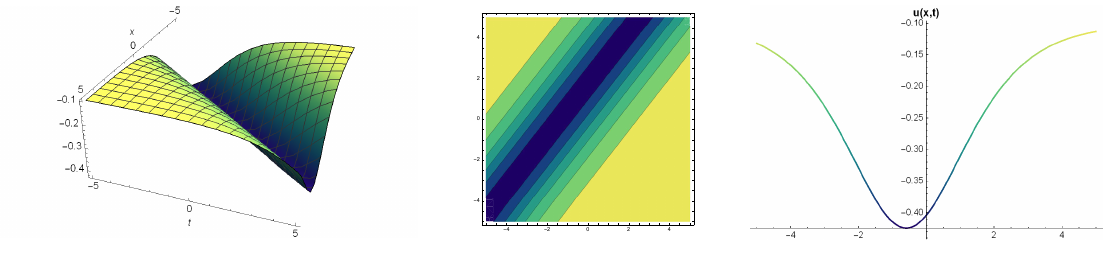
Figure 2. 3D, contour and 2D graphs respectively for p = − 1, µ = − 0.8, A = − 3, a 2 = − 1, a 1 = − 1, q = 2 values of Equation